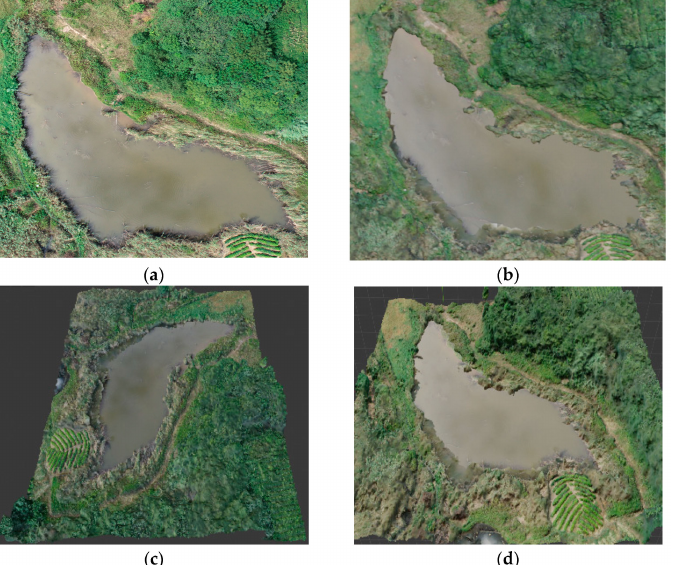
Figure 9. Comparison results of reconstruction effect of water regions. ( a ) is the scene photo captured by UAV, and ( b – d ) are the screenshots of the reconstruction result from three different